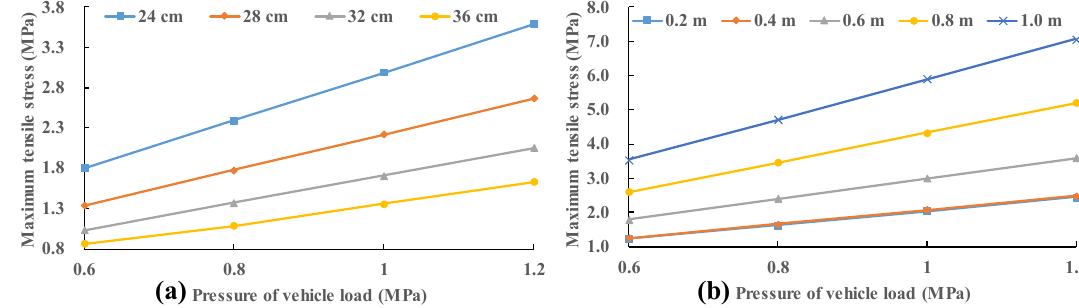
Figure 10. Variation in stress of the slab with various vehicle load: ( a ) void size is 0.6 m; and ( b ) slab thickness is 24 cm.